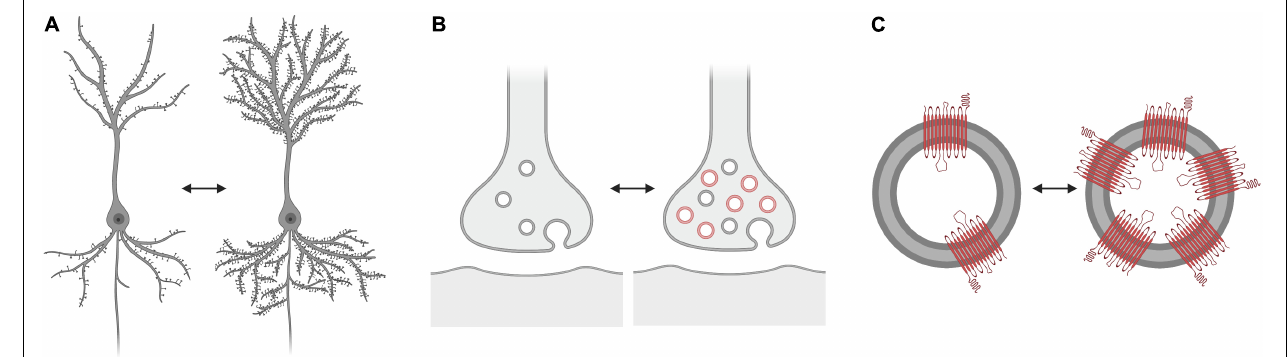
FIGURE 2 | What does “altered SV2A density” represent? Three possibilities: (A) Altered synaptic vesicle glycoprotein 2A (SV2A) tracer binding could be associated with changes in “synaptic density” (exemplified as a change in the number of dendritic spines). (B) Altered SV2A tracer binding could be associated with changes in the number of vesicles in the pre-synaptic terminal, according to the functional state of the synapse, and so with functional properties of the synapses rather than their density. (C) Altered SV2A tracer binding could be associated with changes in the number of SV2A copies in the vesicles. The number of SV2A copies reached by the tracers and thus labeled may also vary. The alternative scenarios (B) and (C) do not necessarily implicate a change in the overall synaptic